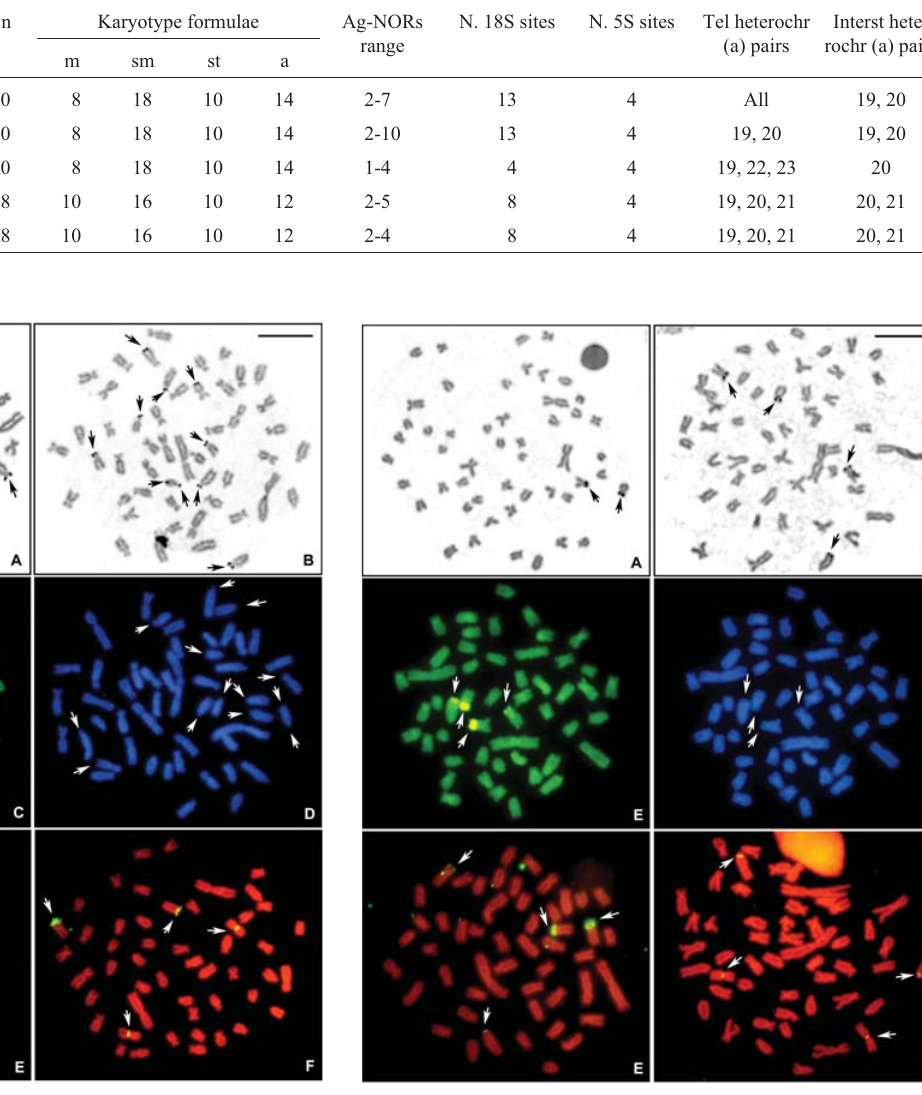
Figure 3 - Metaphases of the karyotypic form B (unidentified species of the Astyanax scabripinnis species complex) evidencing (A, B) the Ag- NOR bearing chromosomes; (C) Chromomycin A 3 positive or GC-rich sites; (D) sequential DAPI negative or AT-negative sites; (E) the 18S rDNA sites; and (F) the 5S rDNA sites. Bar represents 10 μ